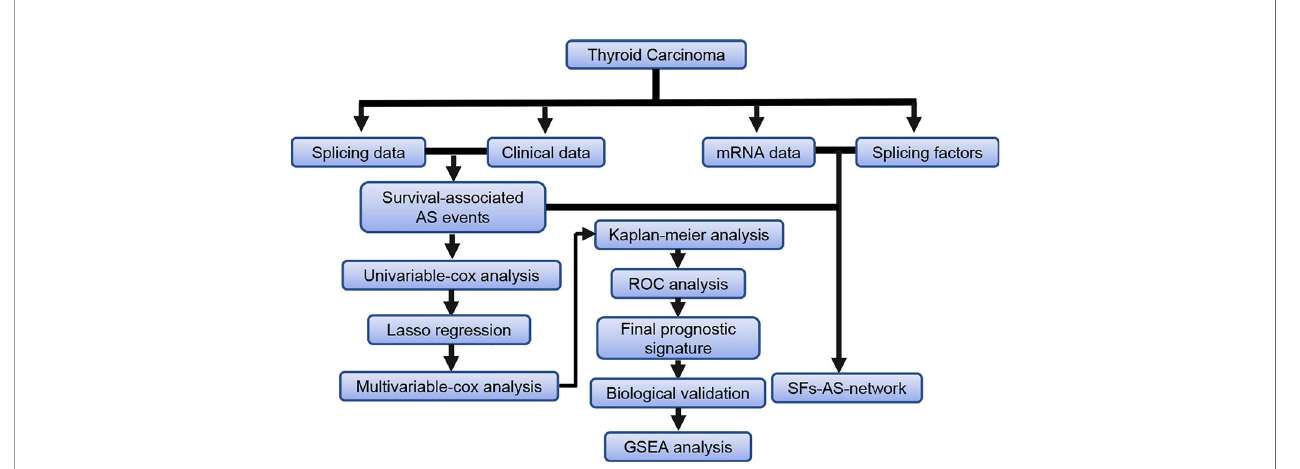
FIGURE 1 | The fl owchart for pro fi ling the AS events in thyroid